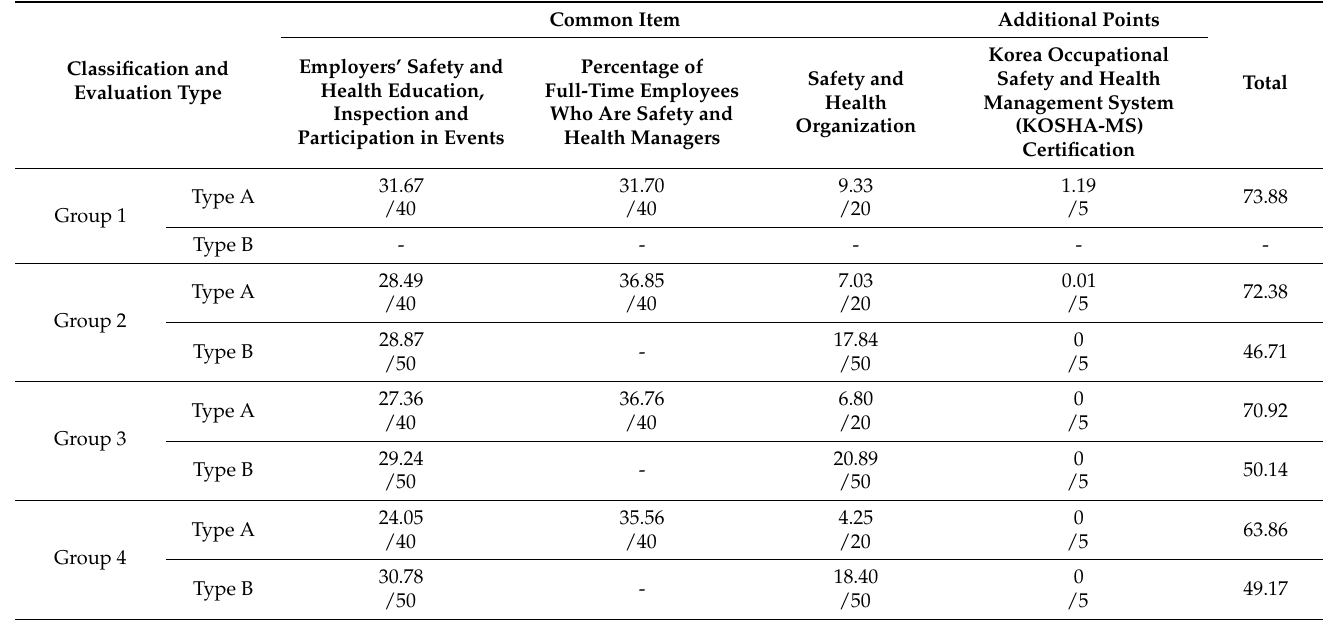
Table 7. Average score for each evaluation item by